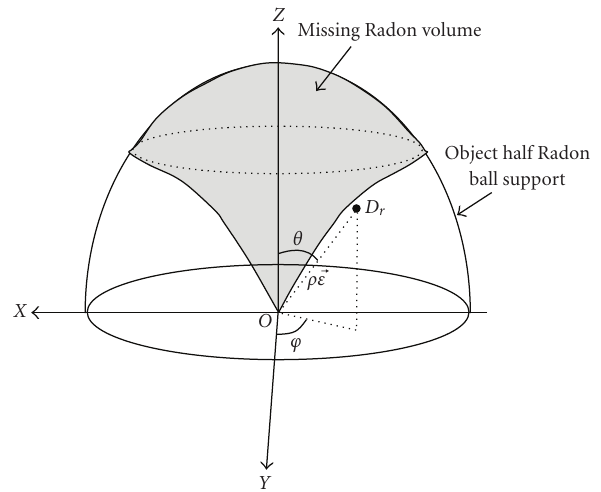
Figure 2: Illustration of the radon point in the radon domain within object Radon